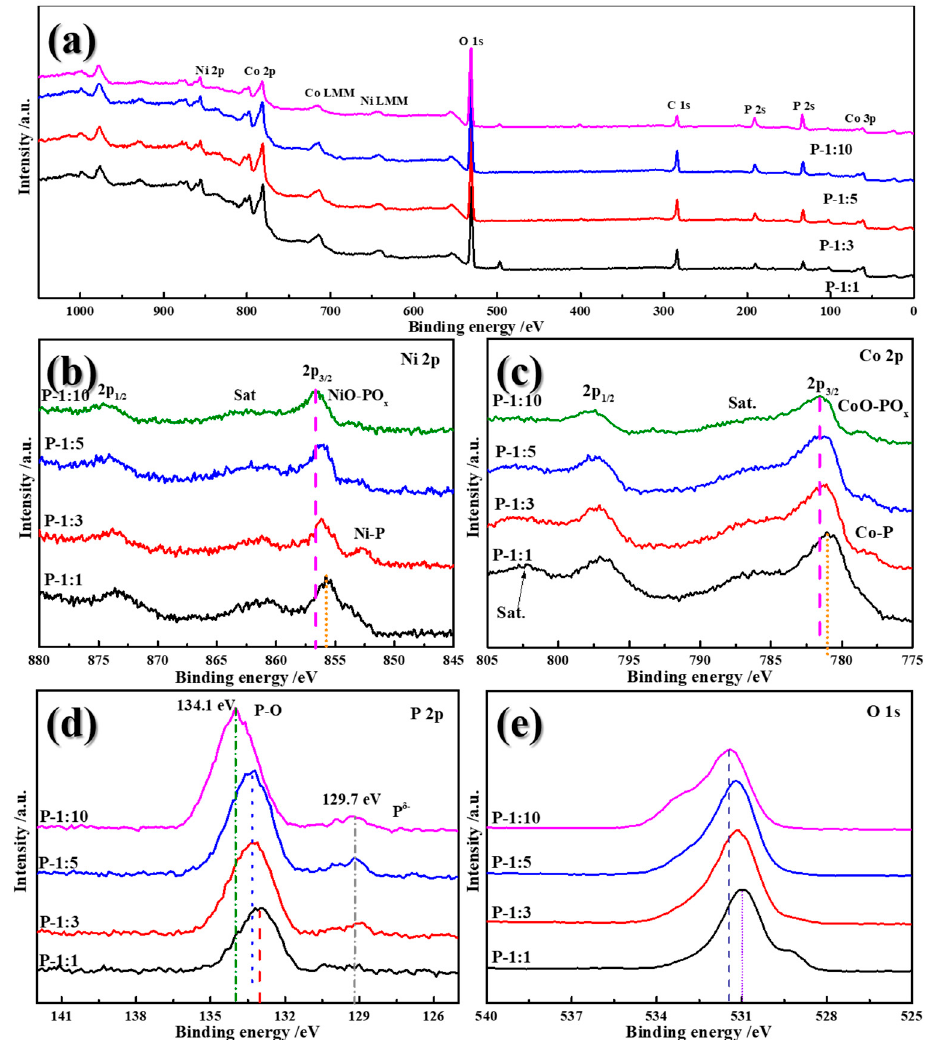
Figure 5. XPS spectra of Ni-Co-P samples with different ratio from ( a ) 1:1, ( b ) 1:3, ( c ) 1:5, and ( d ) 1:10, ( e ) O1s spectra.